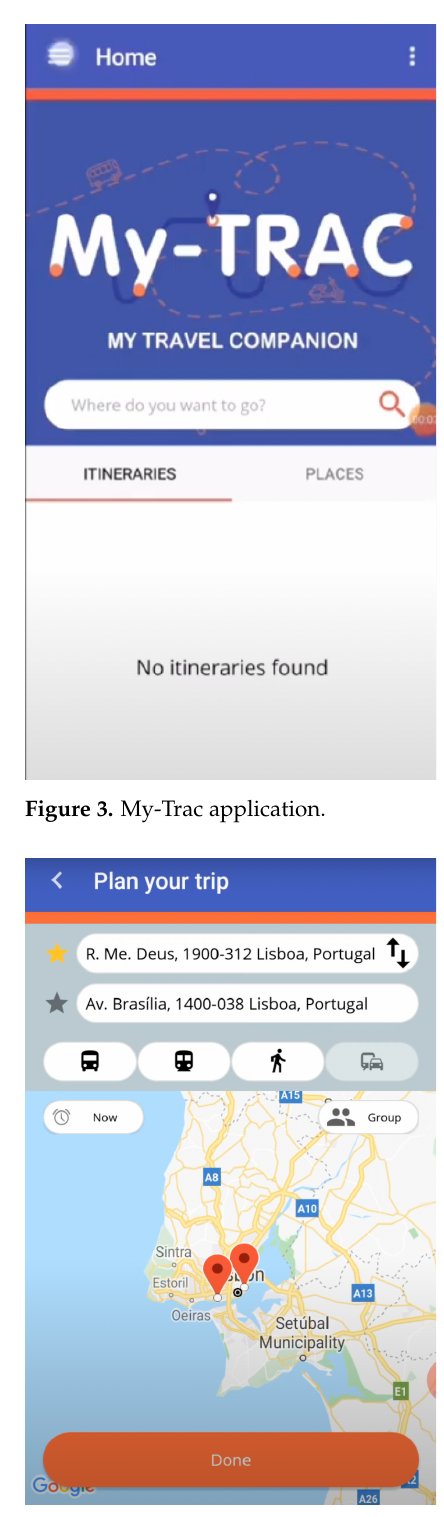
Figure 4. Trip planification using My-Trac